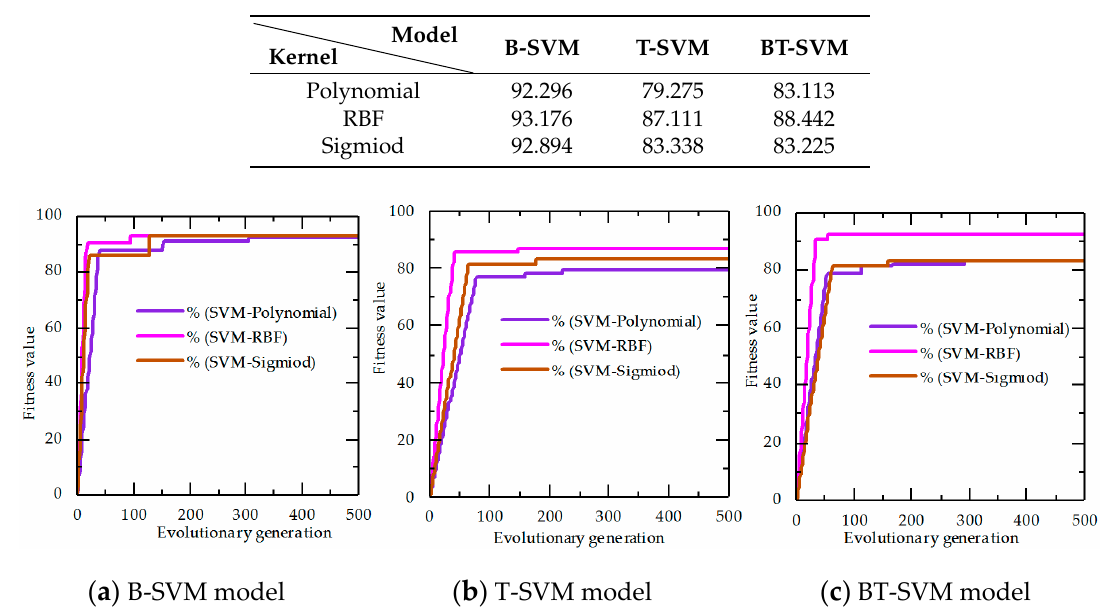
Table 4. Training classification accuracy of SVMs/% with different kernel functions.